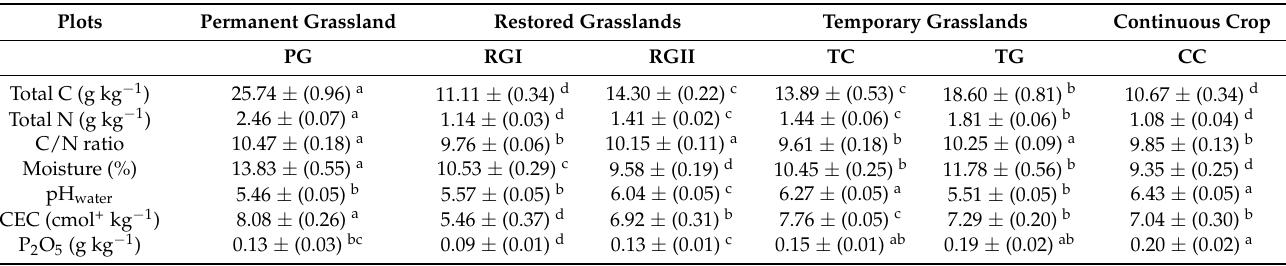
Table 4. Physicochemical characteristics of